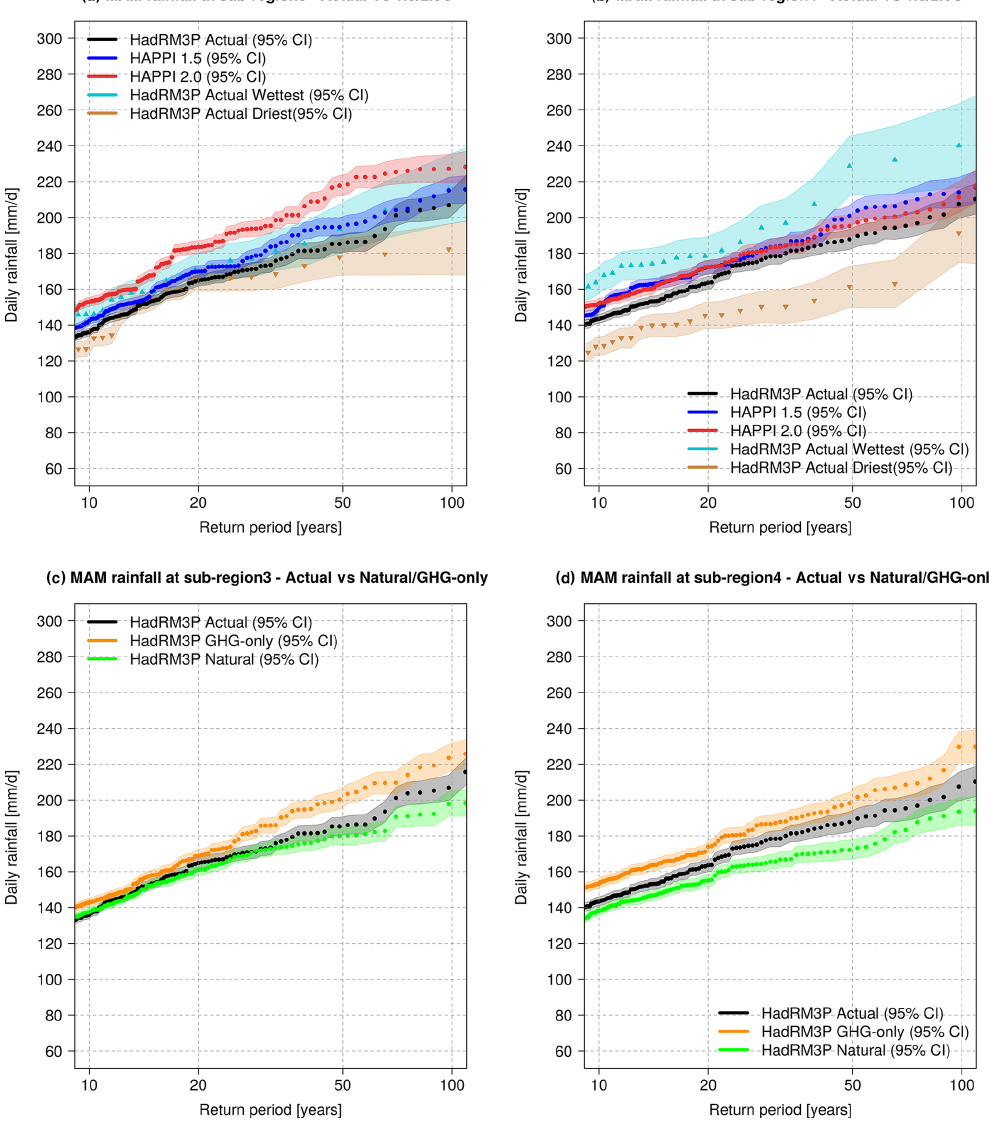
Figure 7. Same as Fig 6, but showing return time plots for MAM daily rainfall under different forcing scenarios over the sub-regions 3 and 4 of